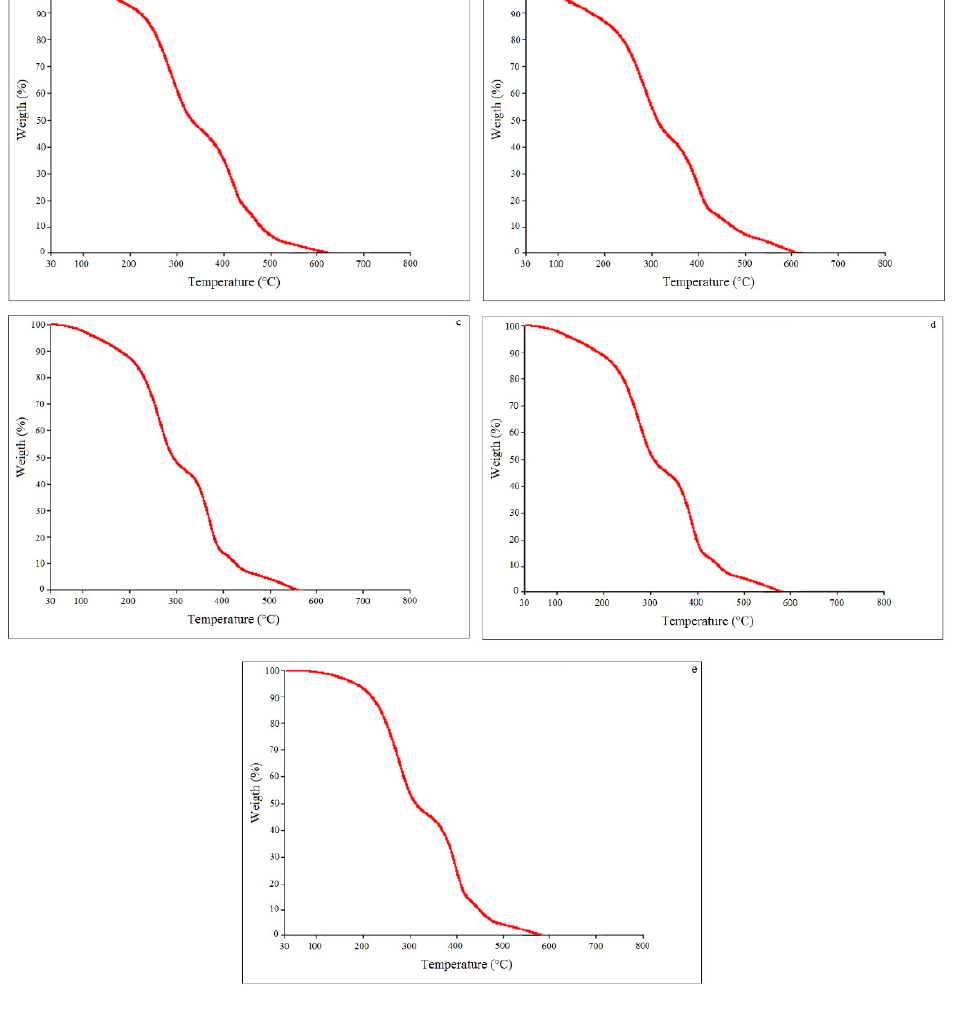
Figure 3. TGA curves of the samples extracted by scCO 2 + EtOH in an atmosphere of synthetic air under different conditions of temperature and pressure. ( a ) 15 Mpa—40 °C; ( b ) 15 MPa—80 °C; ( c ) 25 MPa—40 °C; ( d ) 25 MPa—80 °C; ( e ) 20 MPa—60 °C.